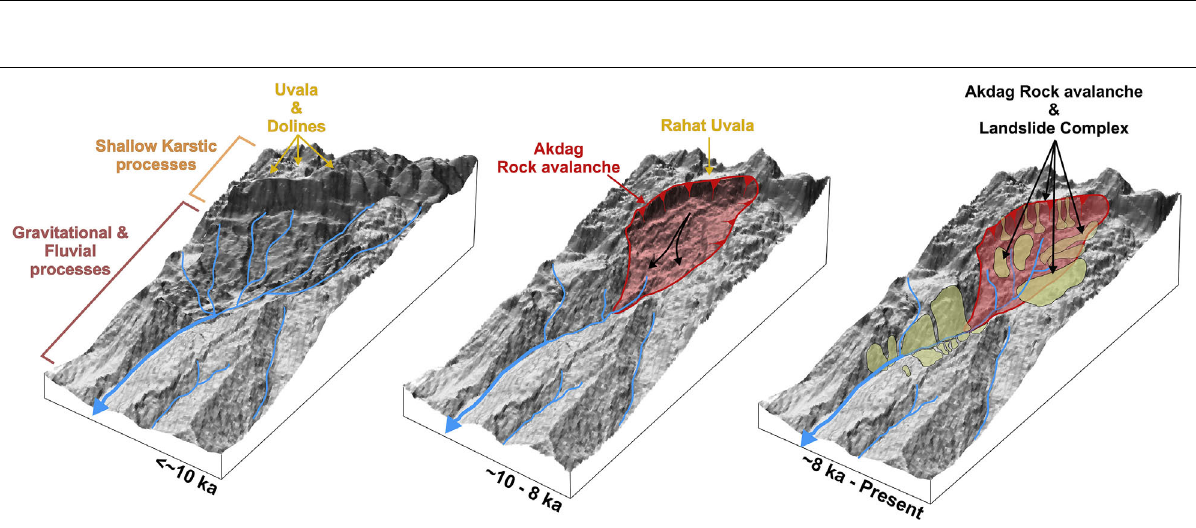
Frontiers in Earth Science |